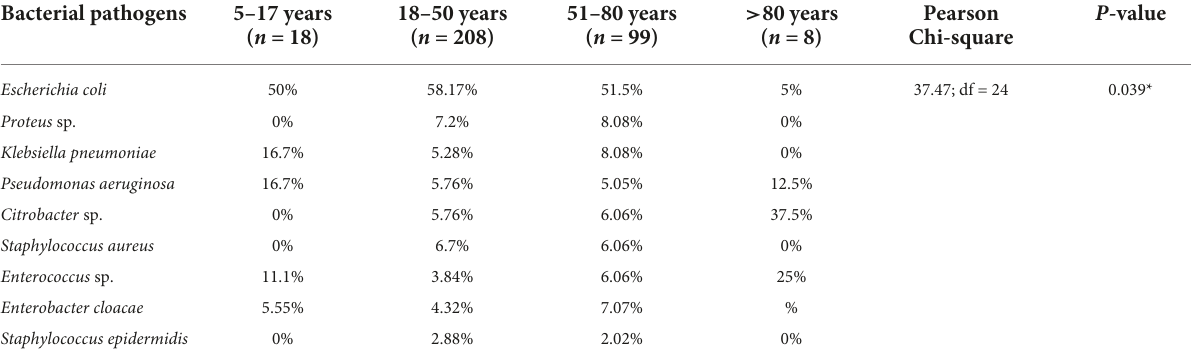
TABLE 3 Distribution of bacteria among the age groups of the study population. Bacterial